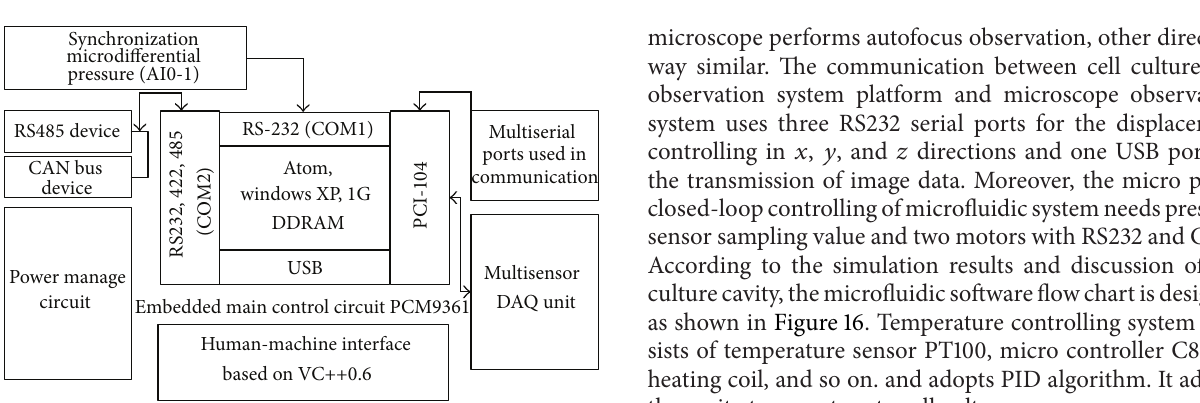
Figure 13: Cell culture and observation system platform diagram. move over a direction for a certain distance, the servo motor powers it. The grating rulers acquire RS232 outputs